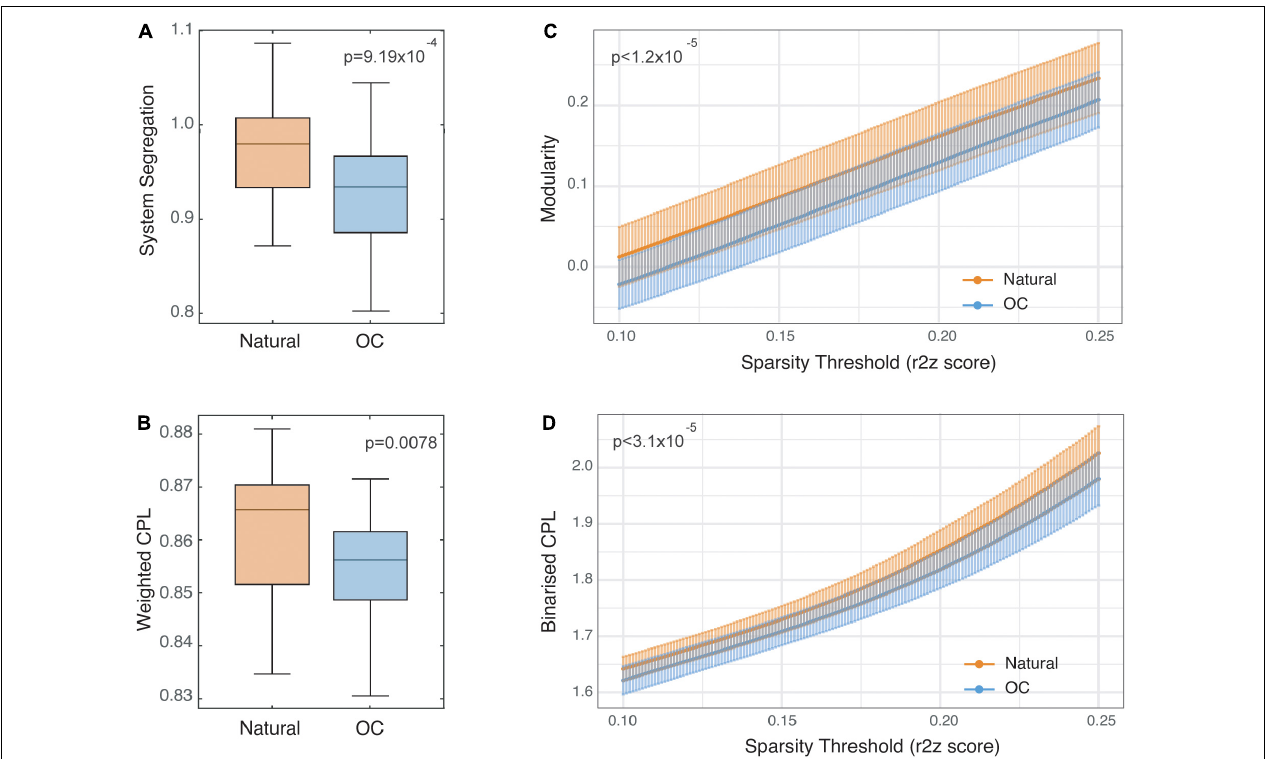
FIGURE 2 | Static functional connectivity comparisons between naturally cycling and oral contraceptive (OC) condition scans. Panels (A,B) show Tukey’s boxplots representing system segregation and weighted characteristic path length values (CPL), respectively. The horizontal lines represent medians, and the vertical limits of the colored area represent the first and third quartiles. Notches represent 95% confidence intervals for comparing medians, calculated as 1 . 58 × IQR √ show modularity and binarized CPL values reported for each condition at a range of sparsity threshold values between 0.1 and 0.25 and are plotted as mean ±